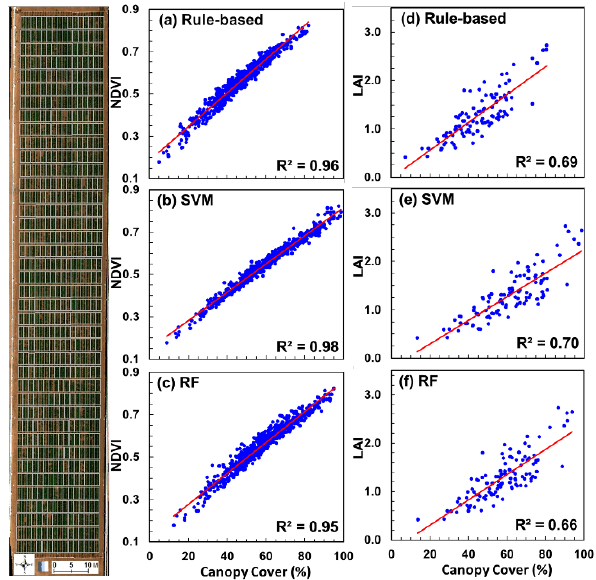
Figure 6. Correlation analysis of canopy cover derived from the rule-based method, SVM, and RF, against NDVI (Normalized Difference Vegetation Index) (a, b, c) and LAI (Leaf Area Index) (d, e, f). Left side image is the RGB true color image of the sorghum filed overplayed with 640